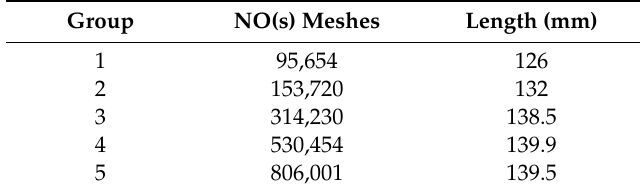
Table 2. Simulation analysis results under di ff erent mesh numbers.